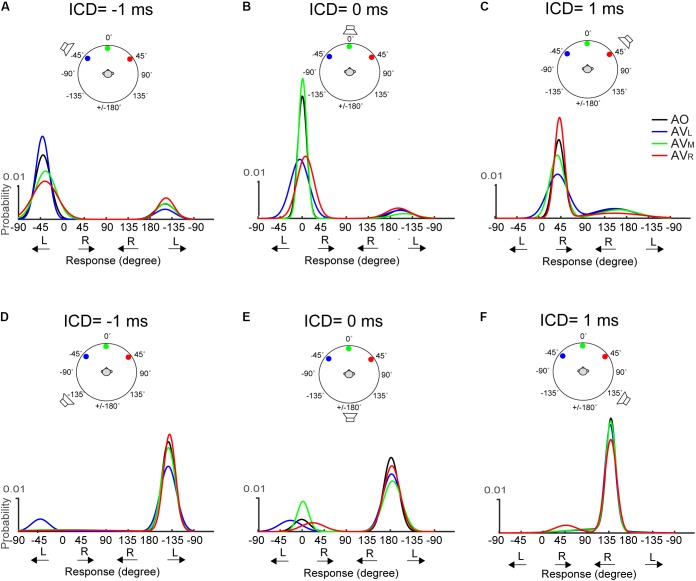
Two-peak Gaussian functions for the front and rear responses in AO and AV conditions at the 50-ms condition. The top (A–C) and bottom (D–F) rows show the results obtained using the two frontal or rear speakers, respectively. The data is presented in the identical format as those in Figure 6.